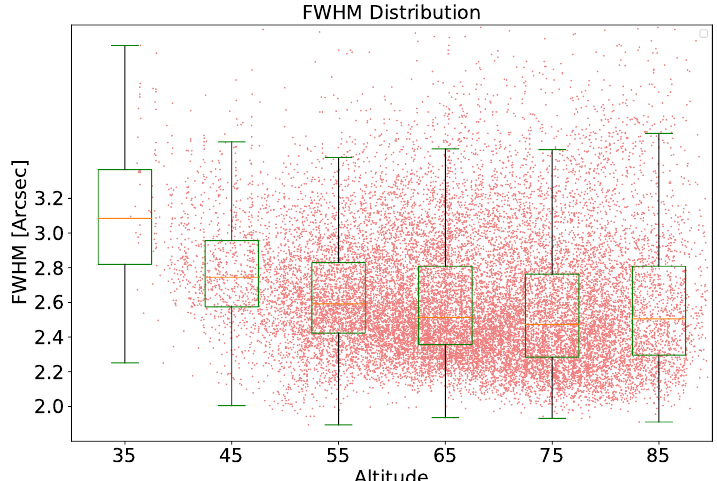
Figure 7. This red points show the AST3-3 statistics for the median FWHM of images in 2021. The box-plot shows the median and standard deviation of altitudes by ten degrees. The FWHM becomes larger when the observation altitude is down to 45 degrees.